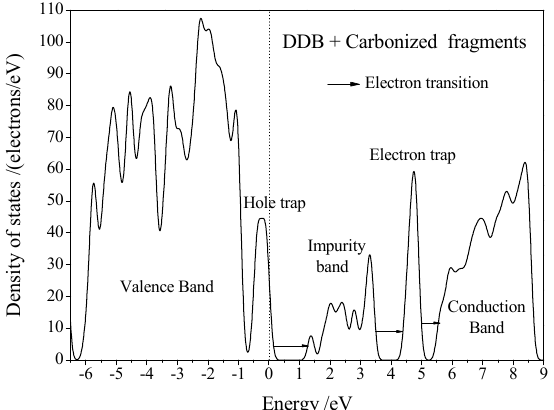
Figure 7. Electronic density of states for mixture system containing DDB molecules and CH, CH 3 , C 3 H 5 , and C 7 H 6 unsaturated broken fragments of DDB molecular chain, with the highest occupied state as reference energy zero, Gauss smearing is set as 0.1 eV.